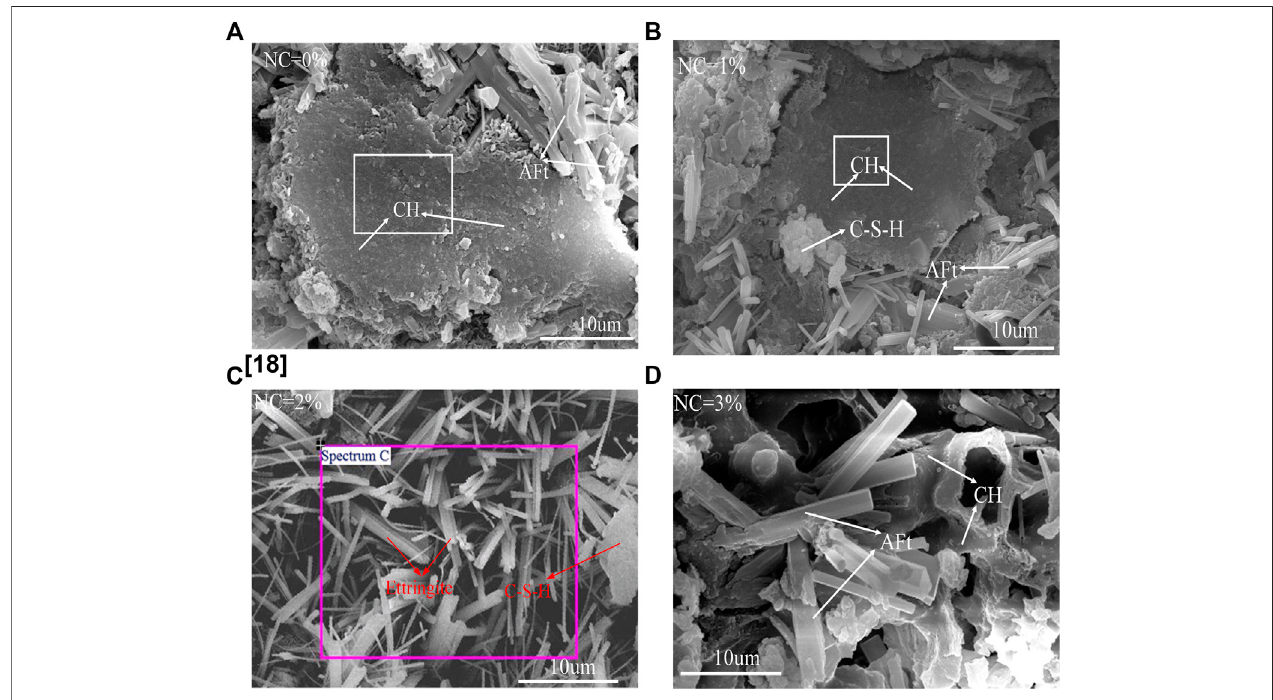
FIGURE 2 | SEM image of hydrated specimens in chloride ion solution for